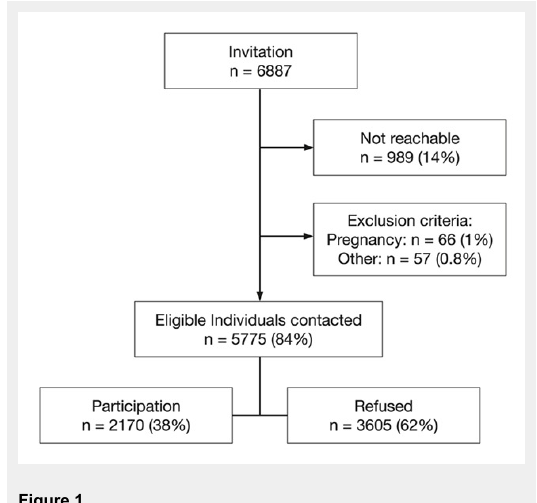
Recruitment of the GAPP cohort study. Flow chart of the recruitment of the GAPP study.